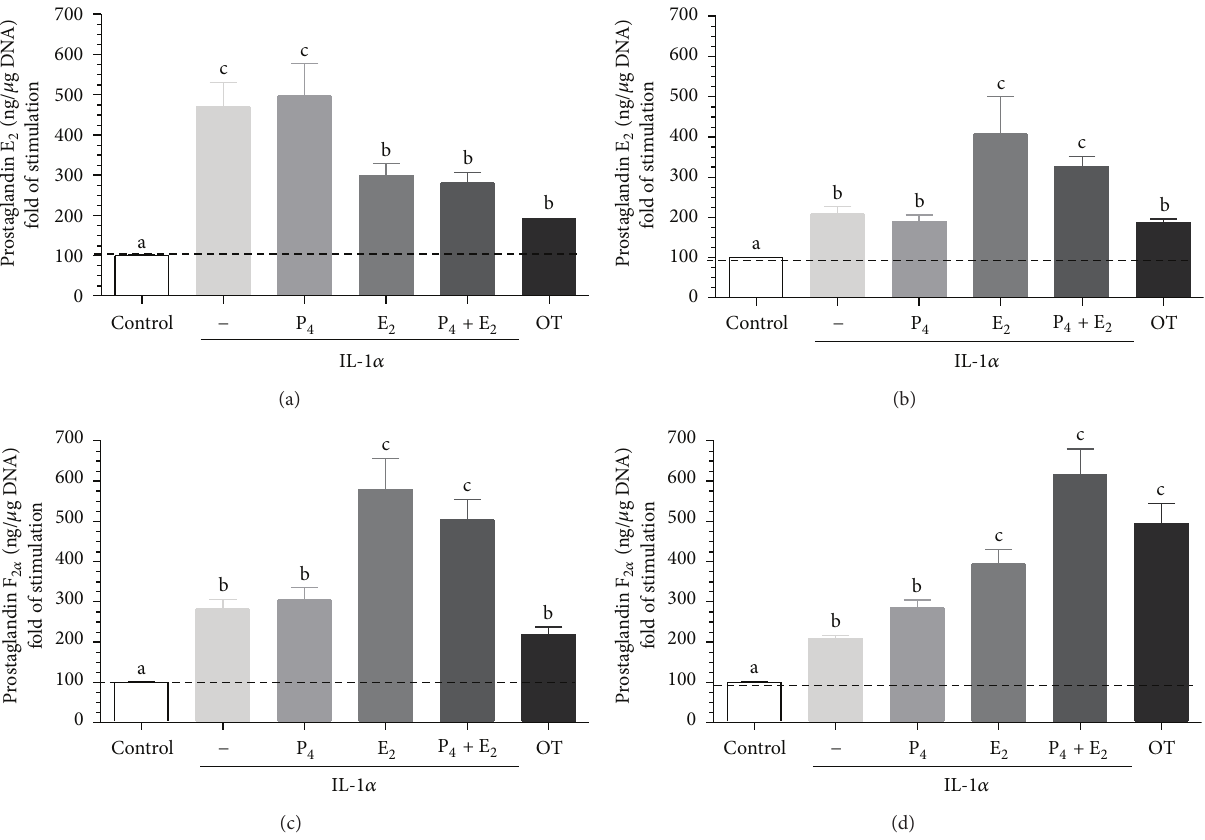
Figure 3: The effect of ovarian steroids on IL-1 𝛼 stimulated PGE 2 and PGF 2𝛼 production by epithelial ((a), (c)) and stromal ((b), (d)) cells. The cells were treated with P 4 (10 −7 M), E 2 (10 −9 M), or P 4 + E 2 (10 −7 /10 −9 M) for 24 h. Then, the medium was replaced with a fresh medium and the epithelial cells were stimulated with IL-1 𝛼 (10ng/mL) for 24 h. Oxytocin (OT; 10 −7 M) was used as a positive control. All values are expressed as n- fold change from control. letters “a,” “b,” and “c” indicate significant differences ( 𝑃 < 0.05 ) between groups, as determined by parametric one-way ANOVA followed by Newmann-Keuls comparison